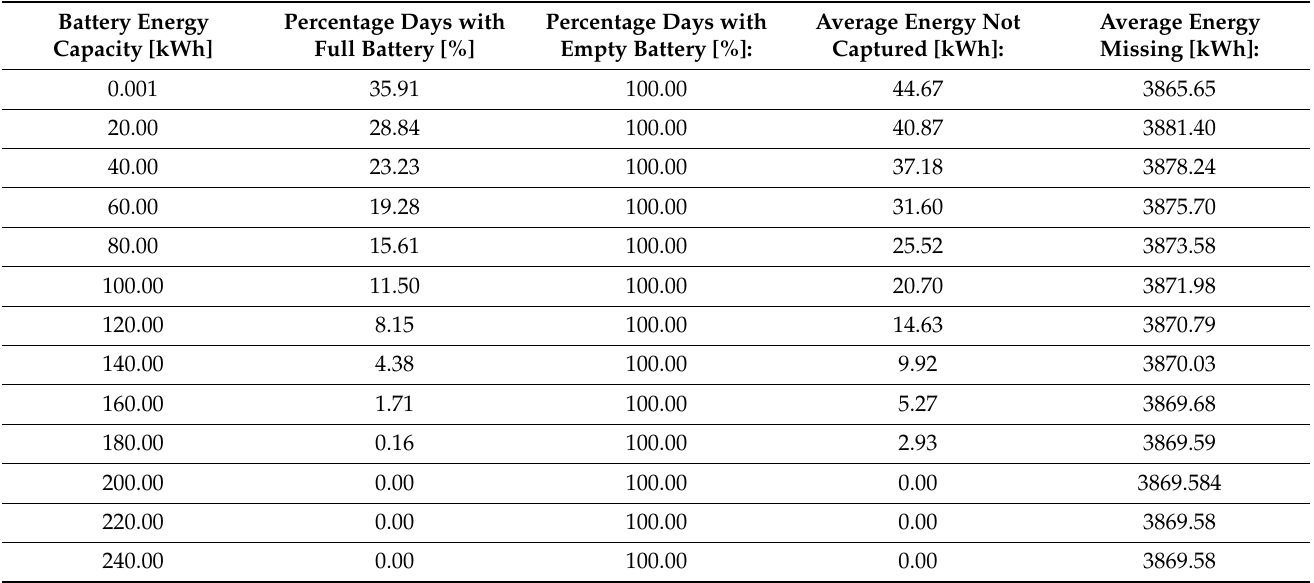
Table 2. The level of use of the energy storage for a 200 kWp photovoltaic installation at the installation